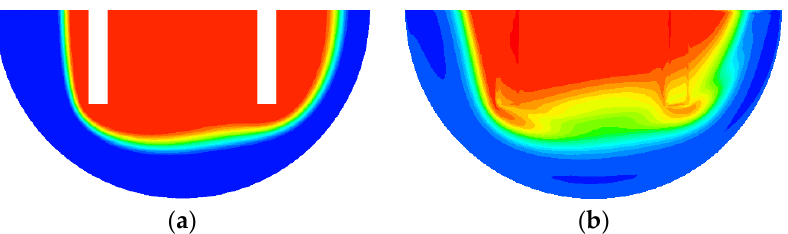
Figure 13. Comparison of concentration distribution in the first semi-circular mixing unit for Re = 10: ( a ) No submergence and ( b ) Submerged, W s = 60 μ m.